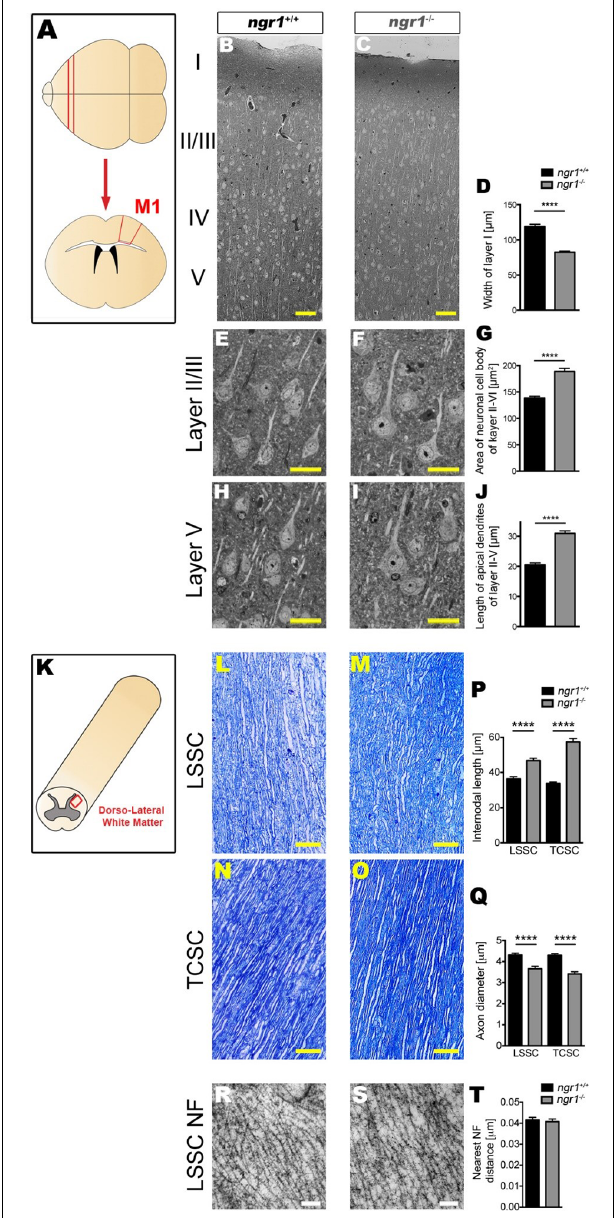
FIGURE 3 | Altered neuronal architecture within the frontal cortex and altered axonal and myelin architecture in the spinal cord of ngr1 − / − mice. For detailed methods please see the Supplementary Information . (A) Illustration of the M1 frontal motor cortex region from which samples were imaged. (B–J) Semi-thin sections from the M1 regions of ngr1 +/+ and ngr1 − / − mice revealed a different neuronal morphology. (B,C) Light microscopic images of the M1 cortical layer from layer I to V in ngr1 +/+ and ngr1 − / − mice (scale bar = 50 µ m). (D) Measurements of the molecular layer width; layer I, was significantly shorter in ngr1 − / − compared to ngr1 +/+ mice. (E–I) Representative high magnification images of pyramidal neurons from (E,F) Layer II/III (H,I) and layer V. Both (G) area and (J) length measurements obtained for the apical dendrites of neurons within the cortical layers II-V were found to be increased in ngr1 − / − compared to ngr1 +/+ mice. (K) Illustration of the dorsolateral white matter region of the spinal cord from which samples ( Continued )